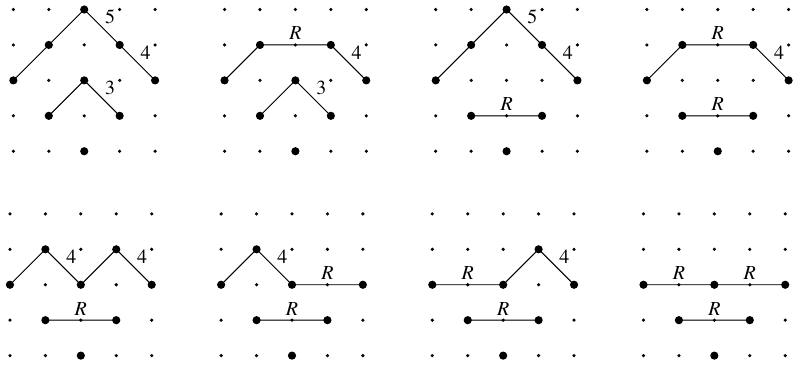
Figure 3: The eight 2-collections of Schröder paths in X 2 , labelled with the weightings from W 0